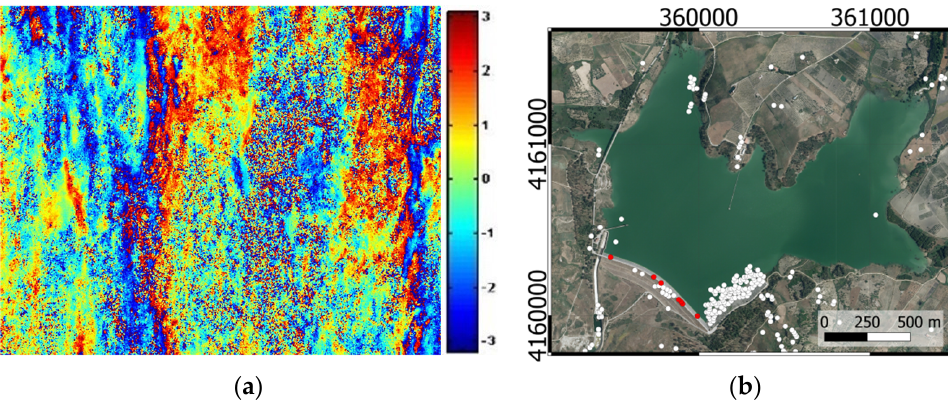
Figure 8. Panel ( a ): interferogram generated (in slant geometry) using the full-graph MBC method: pair 22 June–16 July 2015, normal baseline ~135 m. The phase difference is represented between −π and + π using a rainbow colour ramp. Panel ( b ): High–quality Persistant Scatter (PS) obtained by processing the ascending dataset over-imposed an airborne orthophoto [80] (EPSG 6708) (red dots, selected PS on the dam to interpret the forcing–displacements phenomenon; white dots, remaining PS).